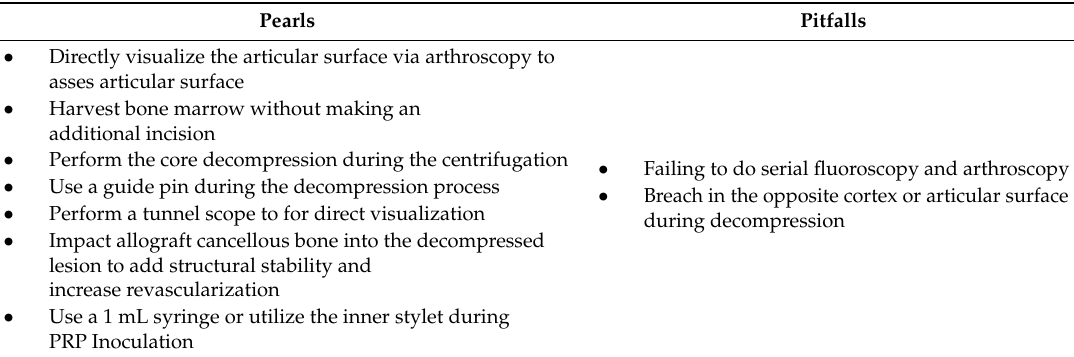
Table 3. Pearls and Pitfalls of